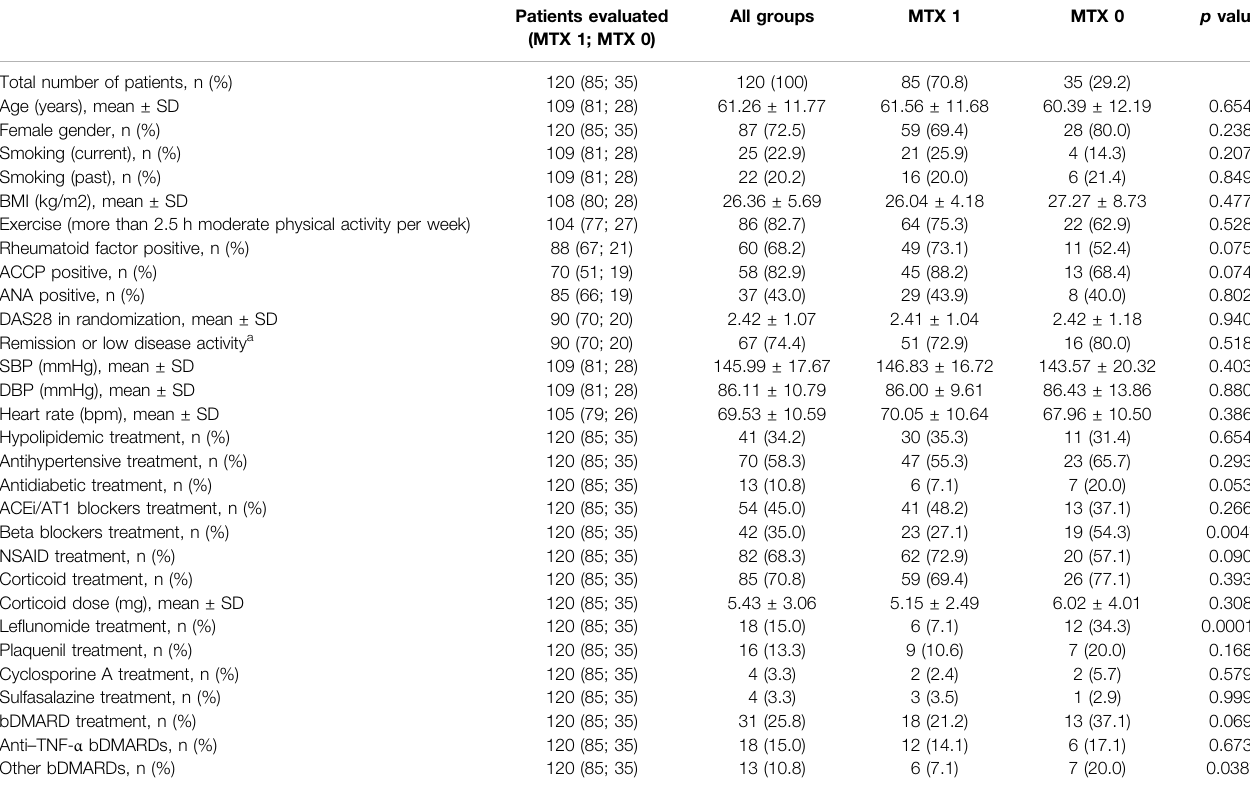
TABLE 1 | Comparison of baseline characteristics between groups of RA patients treated (MTX 1 group) or non-treated (MTX 0 group) with MTX.